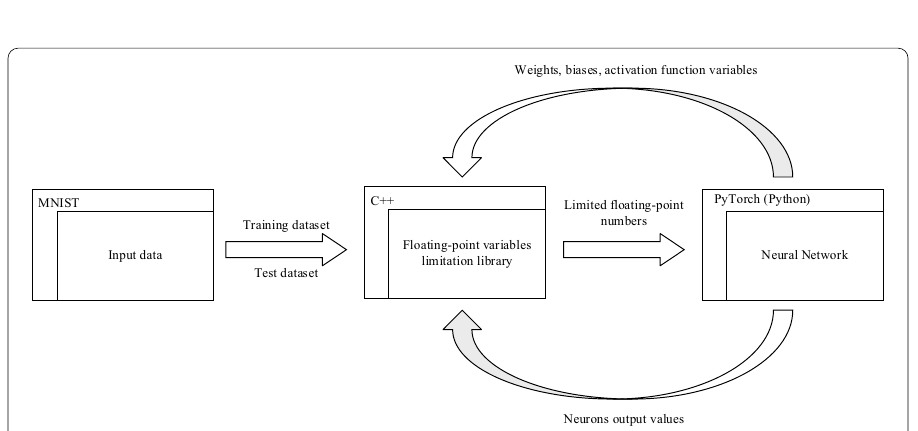
Fig. 4 Overview of the environment used for NN parameters